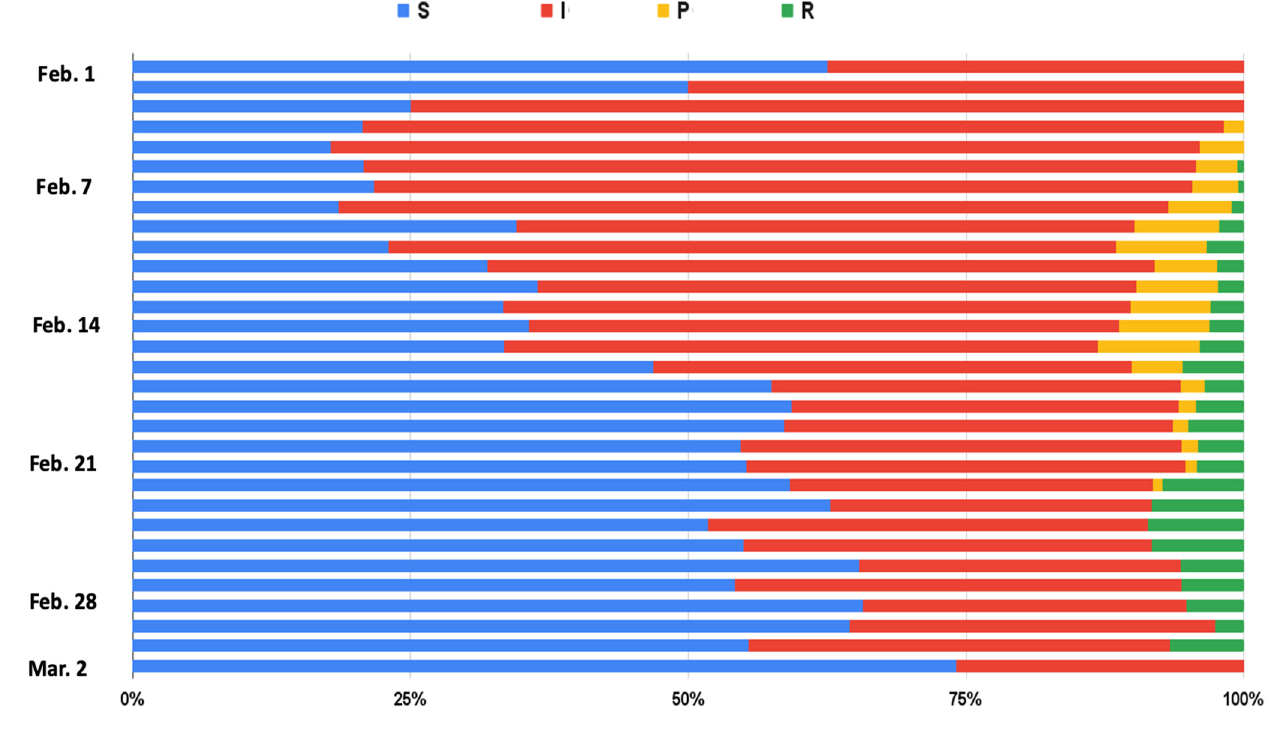
Figure 3. The variations of SIR.